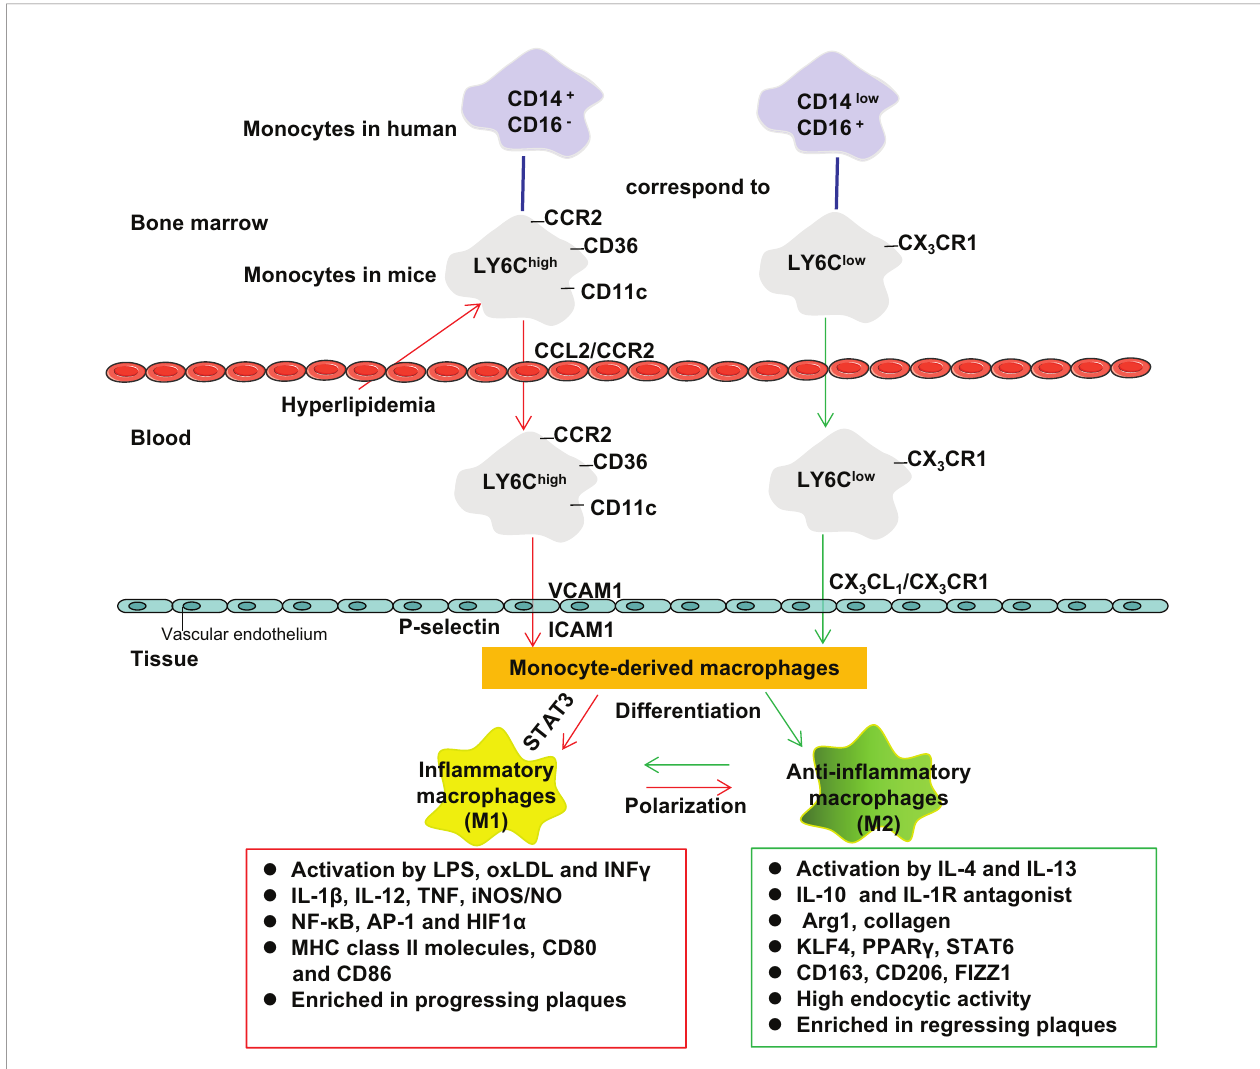
FIGURE 2 | Monocyte differentiation and macrophage polarization. Monocytes are derived from the hematopoietic precursors of bone marrow or spleen and produce the classic lymphocyte antigen 6C (LY6C) high in mice (corresponding to human CD14 high CD16 low monocytes), and nonclassical-LY6C low in mice (corresponding to human CD14 low CD16 high monocytes). LY6C high monocytes highly express CCR2, which can be recruited by chemokines (such as CCL2) to in fl ammatory sites (including atherosclerotic plaques) to play a pro-in fl ammatory effect (it is considered to be the precursor of M1 macrophages). Hypercholesterolemia promotes the production of LY6C high monocytes by inducing the proliferation of bone marrow precursors. LY6C low monocytes (considered to be the precursor of M2 macrophages) highly express CX 3 CR1. These monocyte subpopulations use different chemokine-chemokine receptor pairs to penetrate into the inner membrane, and then differentiate into macrophages in the inner membrane (LY6C high is more likely to differentiate into M1 macrophages, while LY6C low is more likely to differentiate M2 macrophages). M1 macrophages amplify the in fl ammatory effect by secreting pro-in fl ammatory cytokines. M2 macrophages help tissue repair by secreting anti-in fl ammatory cytokines and collagen. AP-1, activator protein 1; Arg1, arginase 1; CCL, C − C motif chemokine; CCR, C-C chemokine receptor; CD, cluster of differentiation; FIZZ1, found in in fl ammatory zone 1; HIF1 a , hypoxia-inducible factor 1 a ; ICAM1, intercellular adhesion molecule-1; INF g , interferon- g ; iNOS, inducible nitric oxide synthase; IL, Interleukin; IL-1R, Interleukin 1 receptor; KLF4, Krüppel-like factor 4; LPS, lipopolysaccharide; NO, nitric oxide; NF- k B, nuclear factor kappa B; PPAR, peroxisome proliferator activated receptor; STAT, Signal transducer and activator of transcription; VCAM1, vascular cell adhesion protein